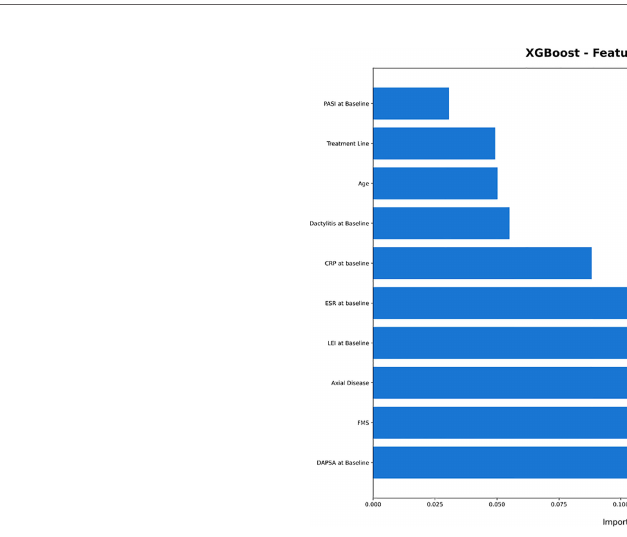
FIGURE 1 | Plot of the feature importance of the attribute core set of eXtreme Gradient Boosting. CRP, C Reactive Protein; DAPSA, Disease Activity in Psoriatic Arthritis; ESR, Erythrocyte Sedimentation Rate; FMS, Fibromyalgia; HAQ-DI, Health Assessment Questionnaire- Disability Index; LEI, Leeds Enthesitis Index; PASI, Psoriasis Area Severity Index; XGBoost: eXtreme Gradient Boosting.